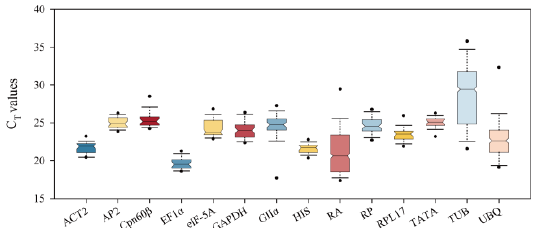
Figure 2. Expression stability of the tested 14 reference genes in all 19 samples. The line shown in the box indicates the median Ct value. The upper edge of each box indicates the 25th percentile and lower indicates the 75th percentile.